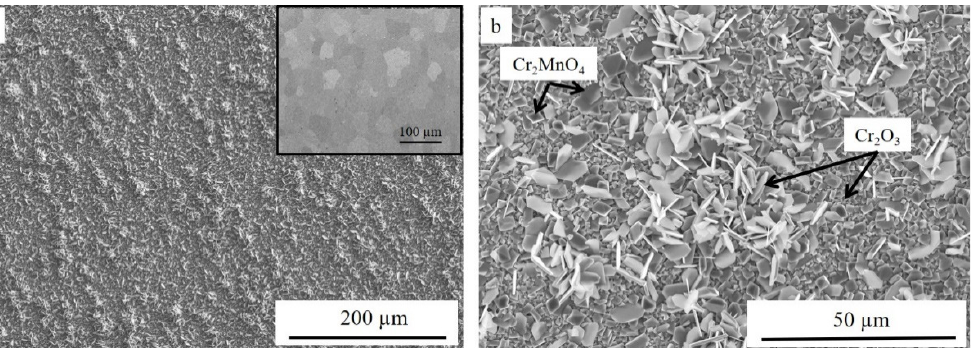
Figure 2. Secondary electron images of the surface of the polished sample after 100 h aging at 800 ◦ C under ambient air: ( a ) global view and ( b ) magnification. Inset in ( a ): global view of the mirror-polished surface before high-temperature